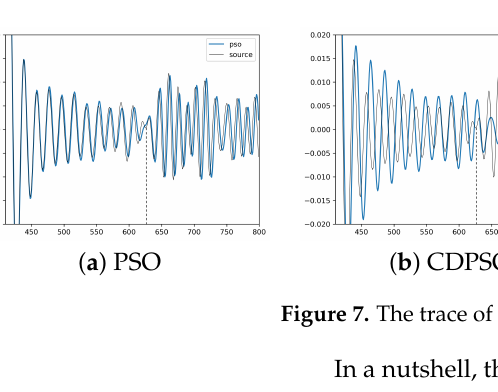
Figure 6. The Chebyshev auto-convolution windows of CDPSO, KH, and PSO.